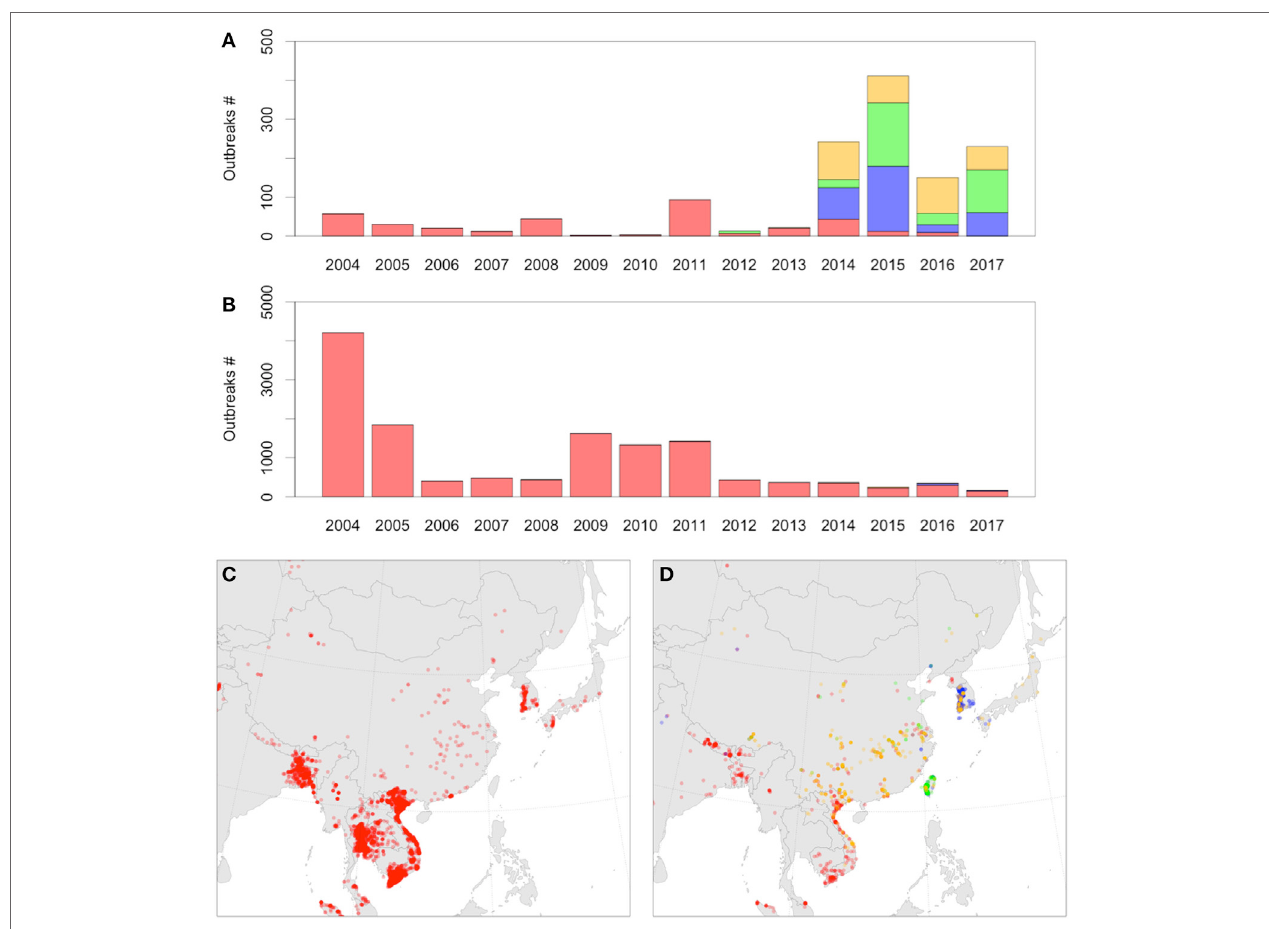
Figure 1 | (a) Number of highly pathogenic avian influenza (HPAI) H5Nx domestic outbreaks in China, North Korea, South Korea, and Japan over time (a) compared to all other Asian countries (B) , colored by subtype: H5N1 (red), H5N2 (green), H5N8 (blue), and H5N6 (orange). (B,C) Distribution of HPAI H5Nx domestic outbreaks in Asia in 2004–2011 (C) and 2012–2017 (d) with the same color code (extraction from the Empres-I database from first Jan 2004 to 13th June 2017, all H5Nx HPAI